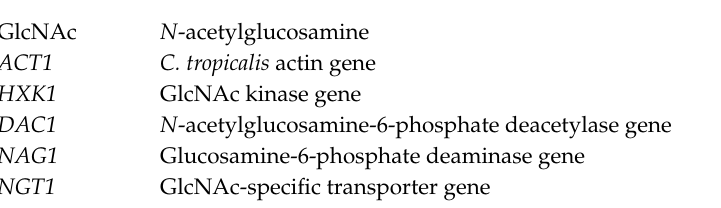
Table S1: Primers used in this